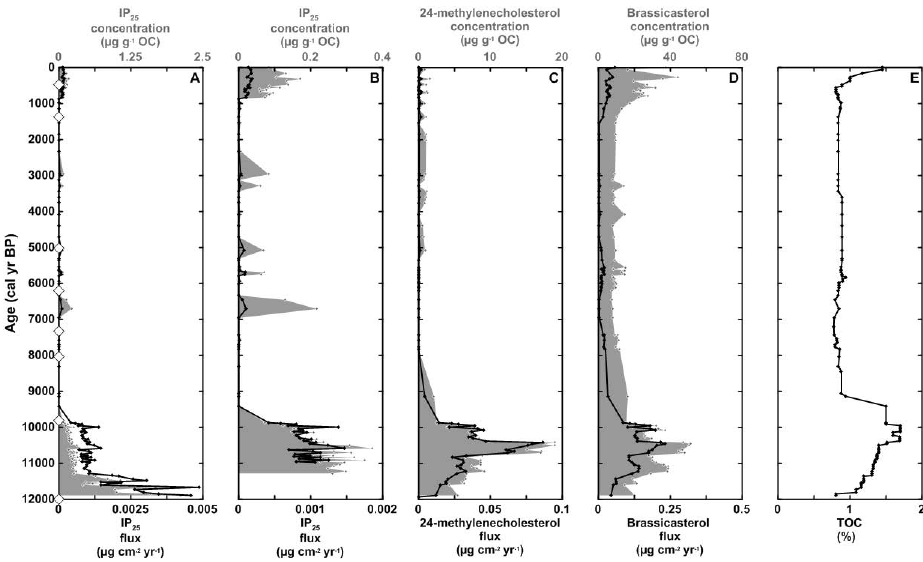
Fig. 6. Biomarker analysis plotted versus calyrBP. The white diamonds on the y axis denote the AMS 14 C converted to calibrated radiocarbon ages. Concentration normalized against organic carbon (grey-filled area) and flux (black line) (note the logarithmic scale for the fluxes): (A) IP 25 for the entire record, (B) IP 25 since 11300calyrBP, (C) 24-methylenecholesterol, (D) brassicasterol and (E) total organic